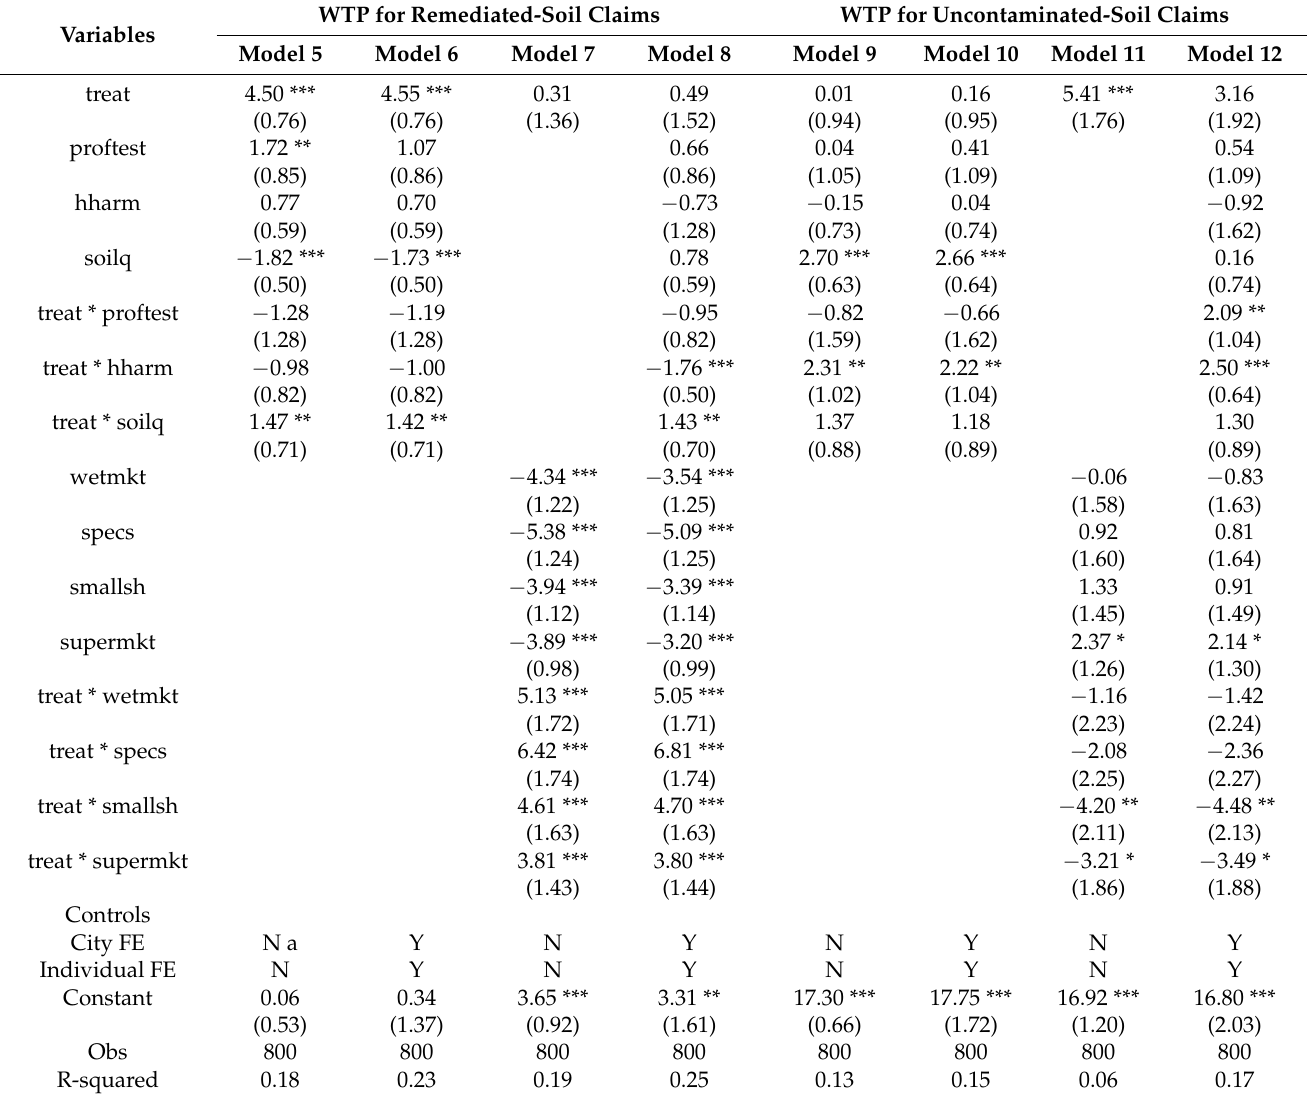
Table 7. OLS interaction item of regression results